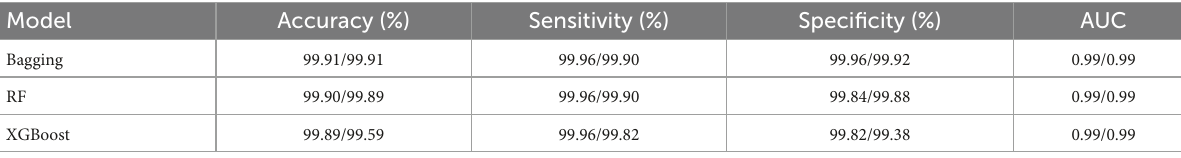
TABLE 4 Performance evaluation of the three classifiers on the training set (ACR/MCR outcomes).